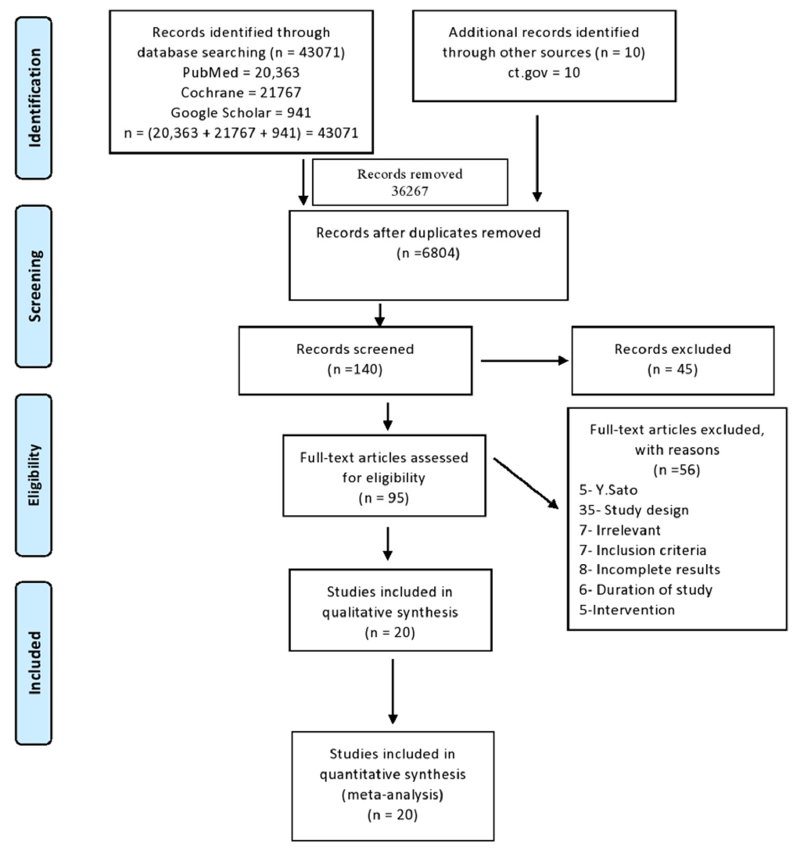
Figure 2. PRISMA: flow diagram of inclusion and exclusion method of study.